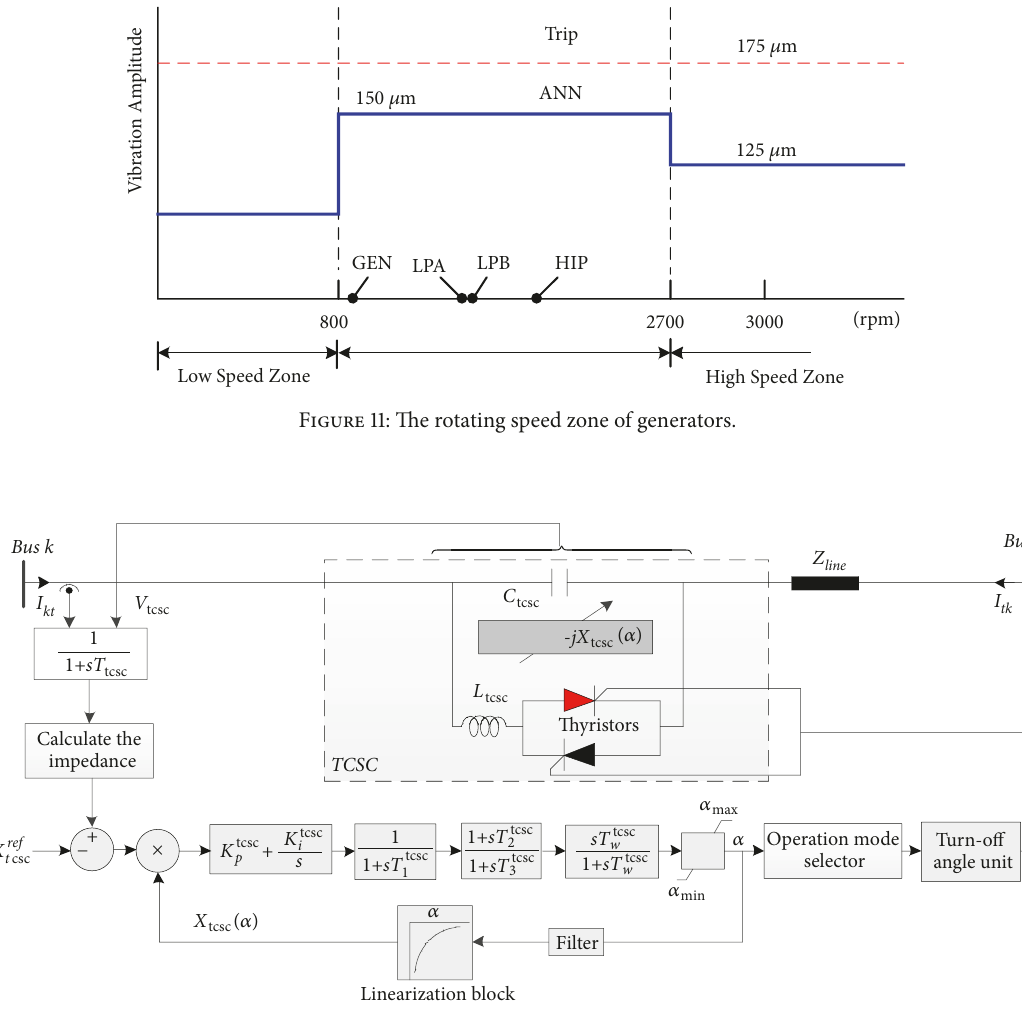
Figure 12: The control strategy for